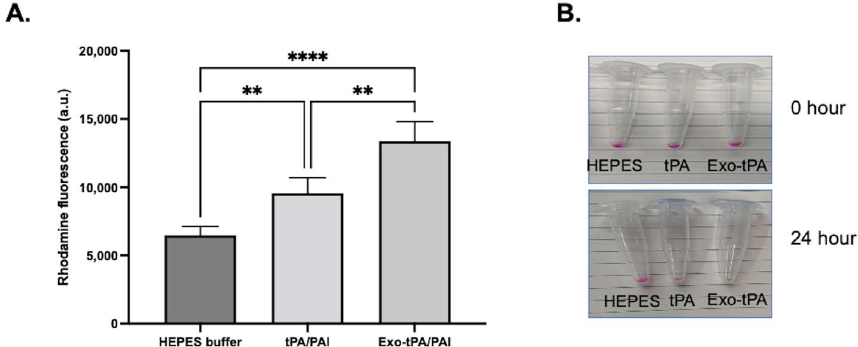
Figure 4. Clot lysis facilitated by exo-tPA and free tPA with equimolar amount of plasminogen inhibitor and plasminogen. ( A ). Clot lysis due to tPA, exo-tPA, and buffer treatments were measured at 24 h by the release of rhodamine from the clots. ( B ). Clot images at 0 h and 24 h after the treatment. n = 3 ± SEM, ** p < 0.01, **** p <